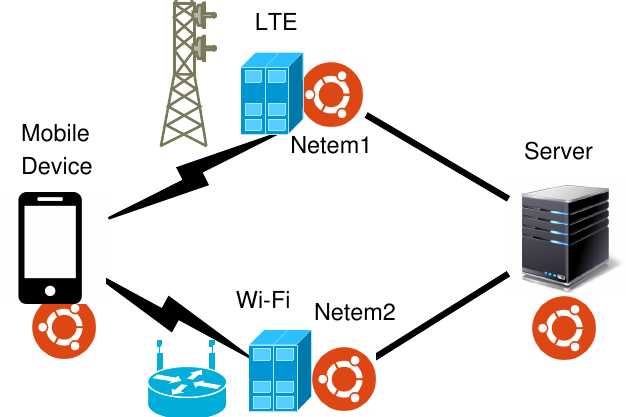
Figure 2. Evaluation